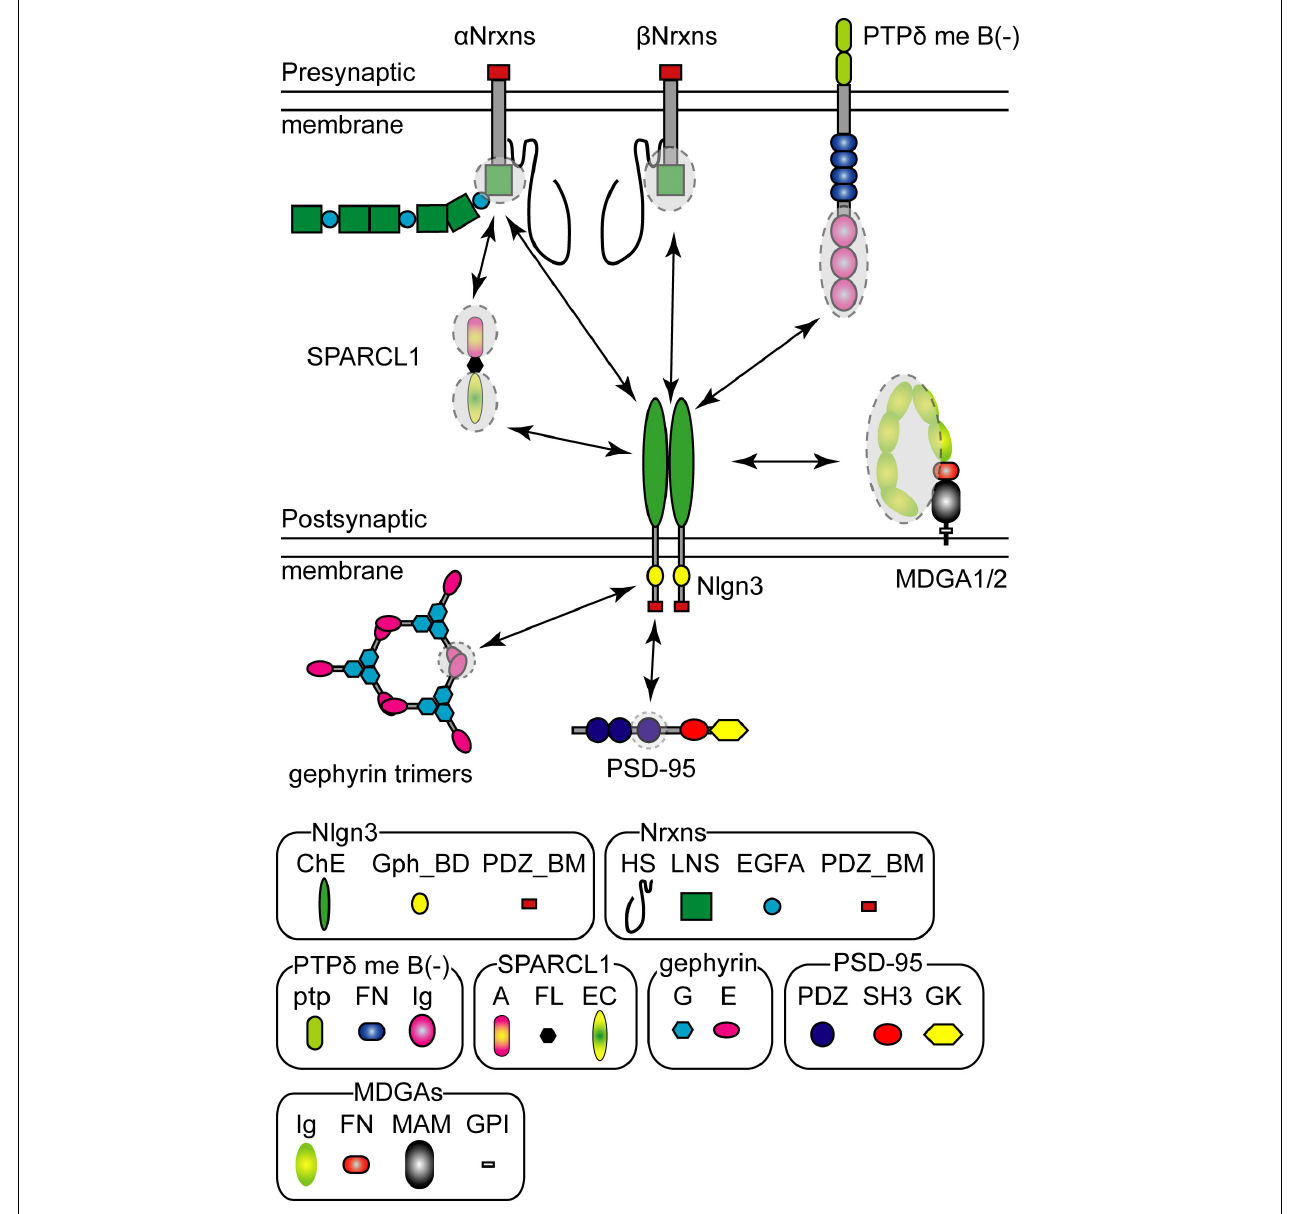
FIGURE 2 | Pre- and postsynaptic Neuroligin 3 (Nlgn3) binding partners. Schematic diagram of the major Nlgn3 binding proteins. Shaded circles with dashed lines indicate the protein domains that interact with Nlgn3. HS, Heparin sulfate; LNS, laminin/neurexin/sex-hormone-binding globulin domain; EGFA, epidermal growth factor-like domains; PDZ_BM, PDZ domain-binding motif; ChE, Cholinesterase-like domain; Gph_BD, Gephyrin binding domain, ptp; protein tyrosine phosphatase domain; FN, fibronectin type III domain; Ig, Ig-like domain; A, acidic domain; FL, follistatin-like domain; EC, EF hand Ca 2 + binding domain; G, G-domain; E, E-domain, PDZ, PDZ domain; SH3, Src-homology-domain-3; GK, guanylate kinase domain; MA, MAM domain; GPI, glycosylphosphatidylinositol